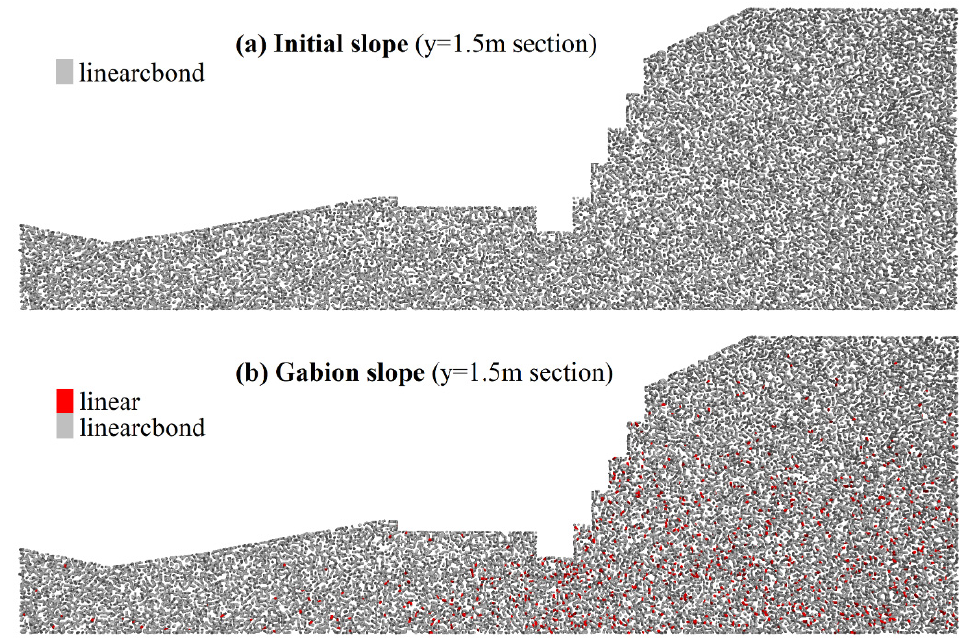
Figure 24. Distribution of the contact bond model. Section of y = 1.5 m.